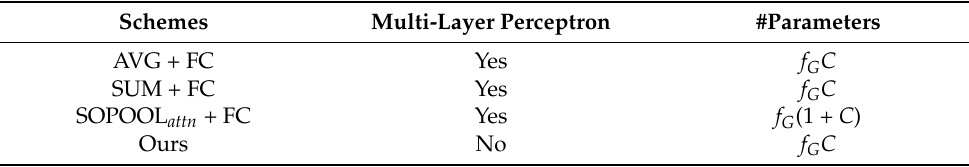
Table 1. Comparison on the amount of